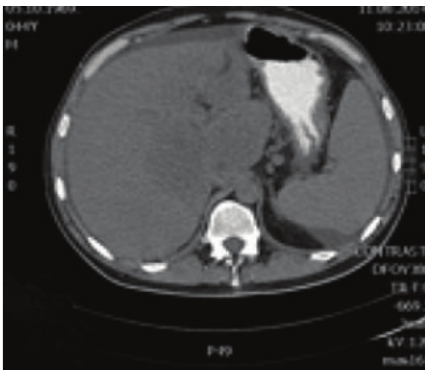
Figure 3: Color Doppler shows no signs of vascularization centrally, with only slight signs of vascularization around periphery.